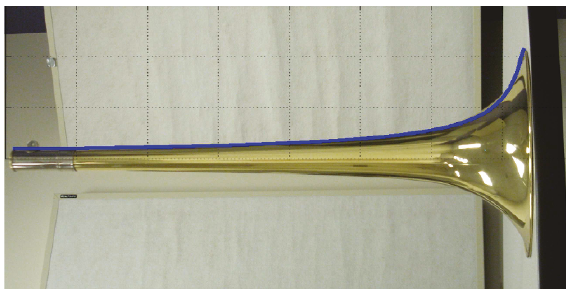
Figure 14: The profile of the bell showsa closefit to the equation for the Bessel horn, given in (21), using the parameters from Table 1.